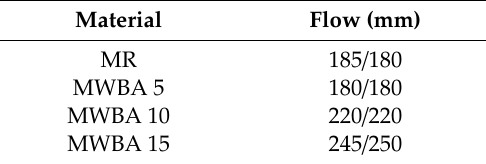
Table 6. Workability of fresh mortars.